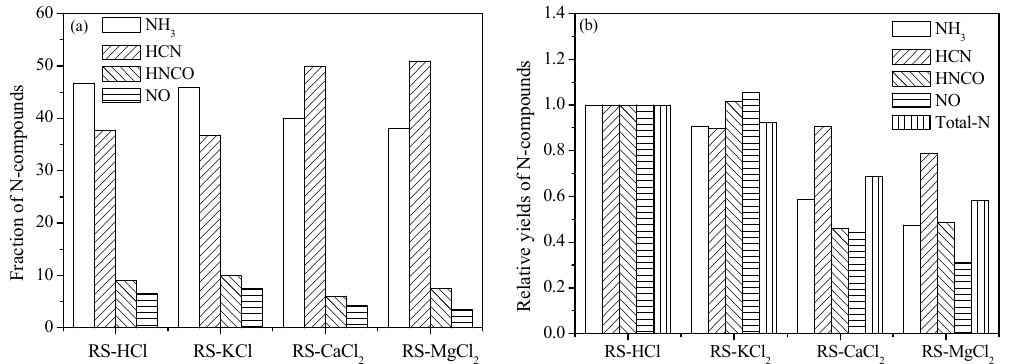
Figure 7. Selectivity and relative yields of N ‐ compounds with AAEM additives. ( a ) Selectivity; ( b ) yield.